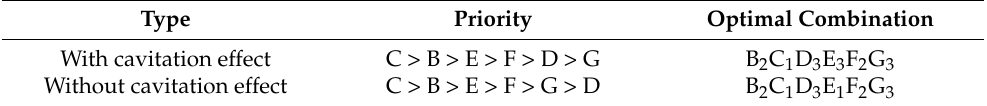
Table 3. Optimal combination of test